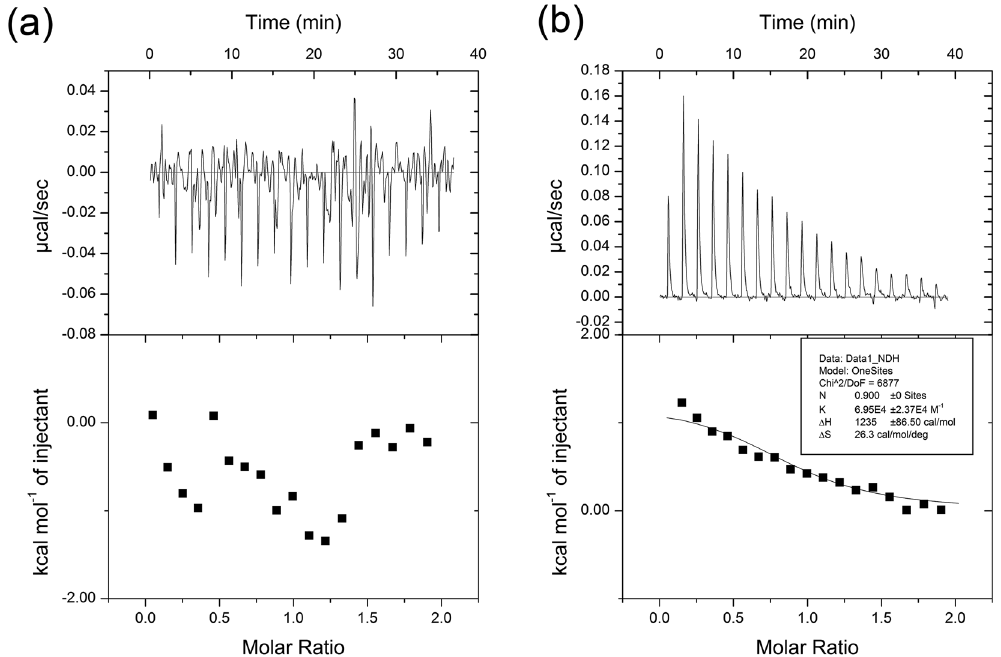
Figure 4. ITC experiments and interaction studies of the YhdE_D70A mutant with Mn 2 + and dTTP. ( a ) ITC titration of 400 μ M Mn 2 + into 40 μ M YhdE_D70A. ( b ) ITC titration of 400 μ M dTTP into 40 μ M